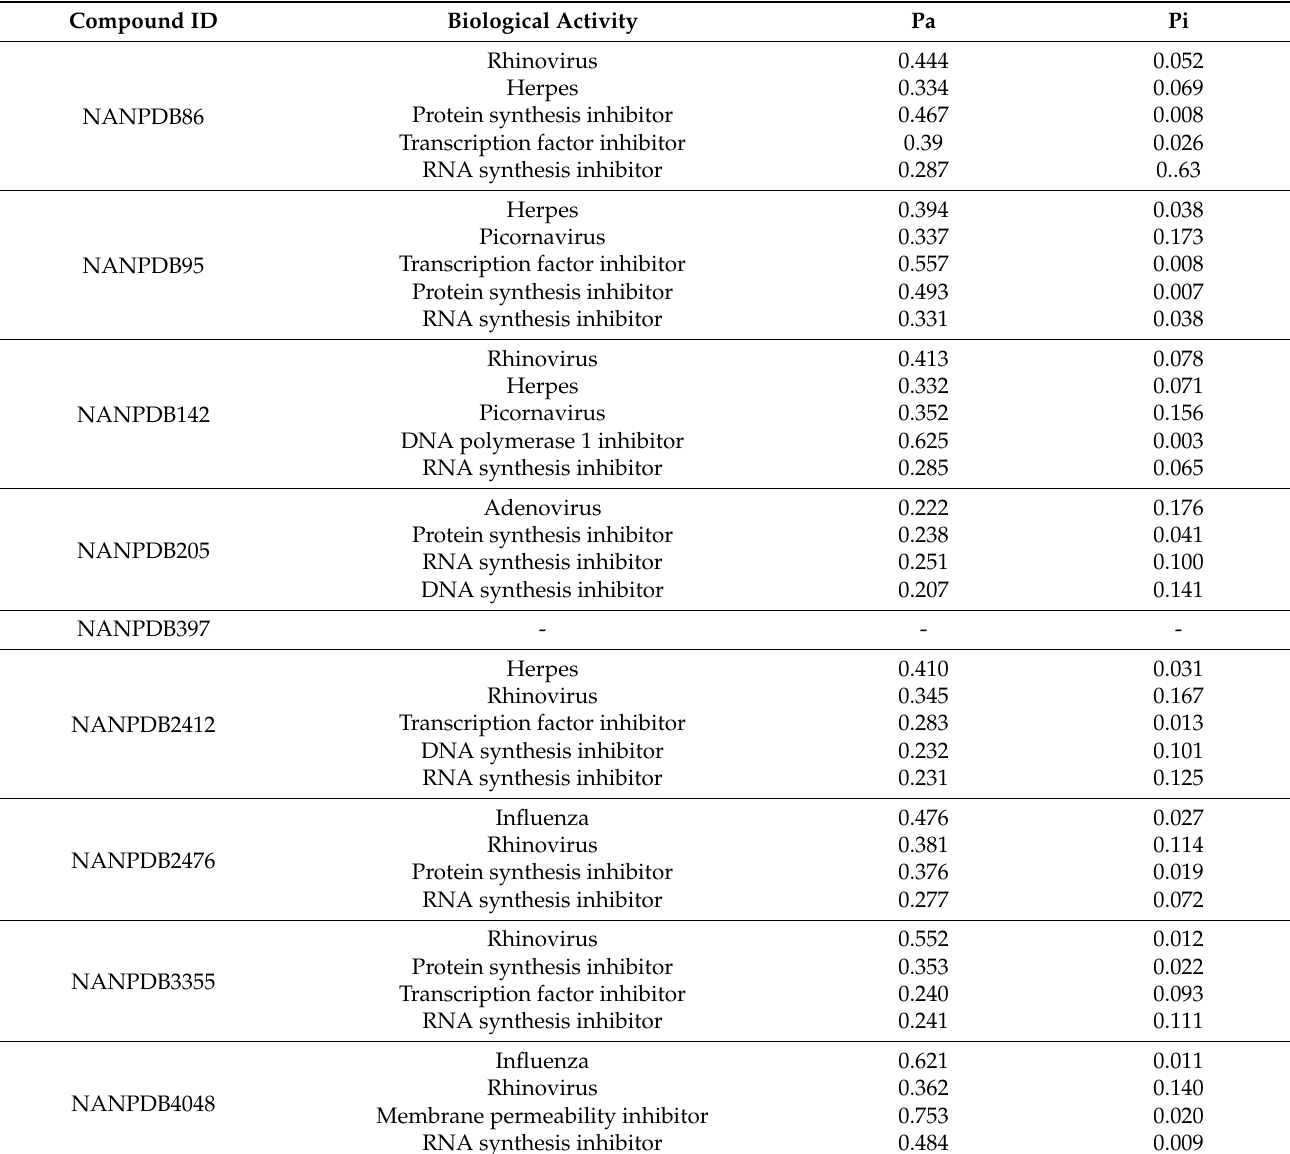
Table 5. The anti-viral activity prediction of the selected